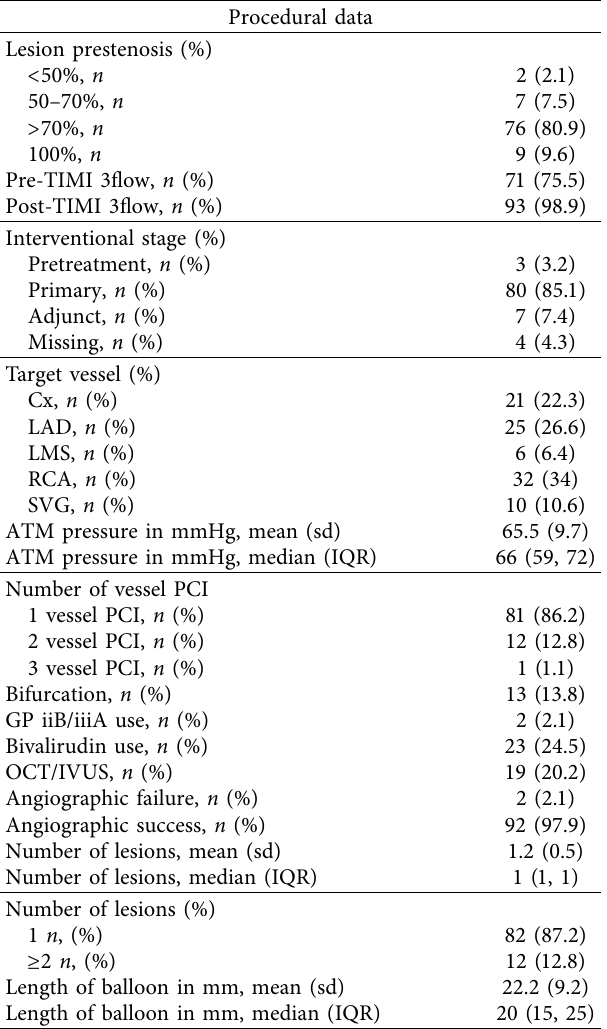
Figure 2: Time to mortality.